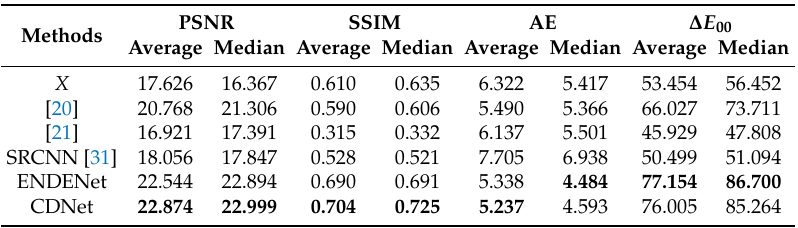
Table 1. Average and median values of the methods tested in the current work when the whole dataset (128 samples) was